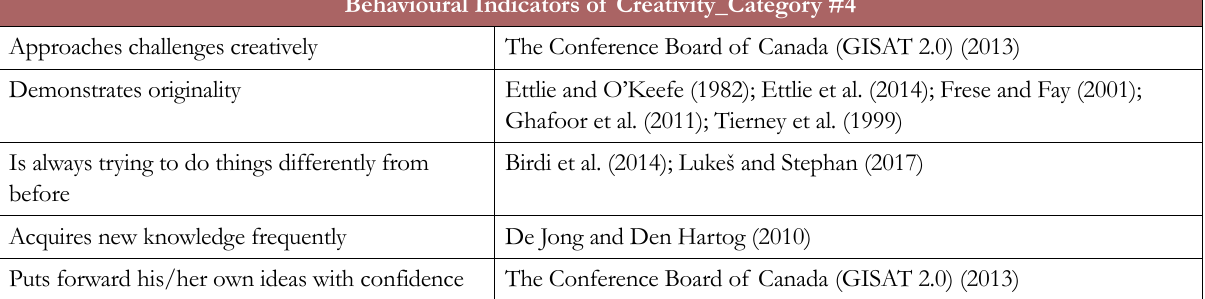
Table 6. Behaviours showing “creative